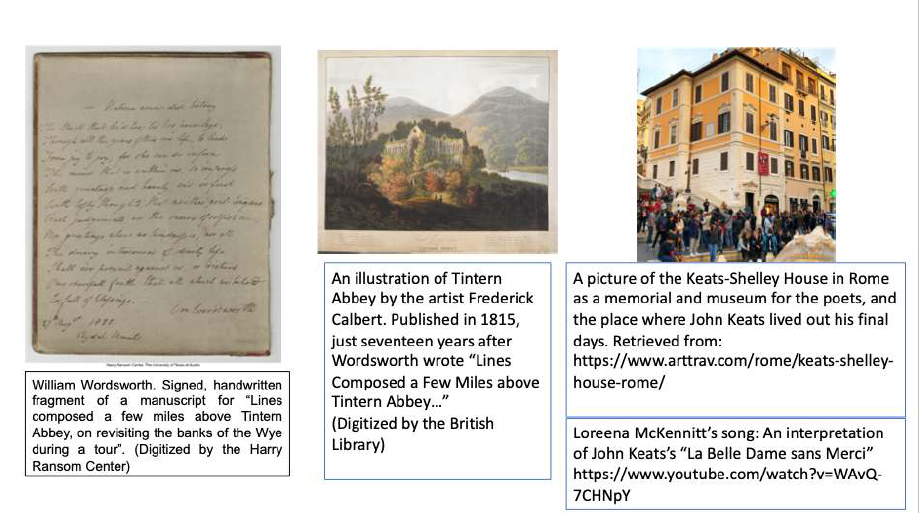
Figure 9: Illustrations from student